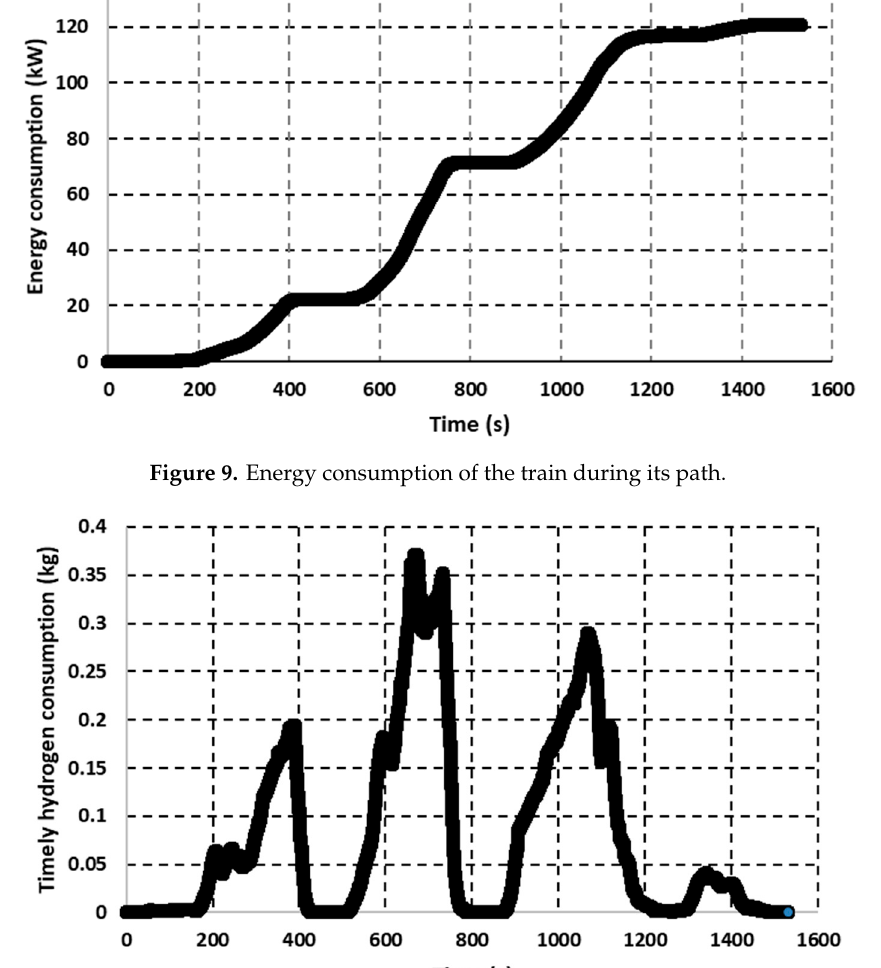
Figure 11. Hydrogen consumption for one trip. 4. Conclusions In this study, a hybrid fuel cell powertrain was conceptually designed for use in Union Pearson drive cycle in Toronto, Ontario, Canada. The repeatable drive cycle of the Union Pearson Express trains was extracted and used in obtaining the time-dependent power demand profile, “duty cycle”. To size the powertrain, four major subsystems were estimated as the primary components of interest, and the appropriate commercialized subsystems put forward in the calculations to investigate the feasibility of the implementing the topology of interest. The calculations showed that a hydrogen/battery hybrid powertrain was able to generate an average power demand of 283.3 kW and peak power demand of 1335 kW, which was needed to meet the drive cycle of the trains and the route geometry requirement based on an empirical data extracted from the working trains. In the development of the powertrain topology, the fuel cell packs were designed to supply the time average power demand of about 283.3 kW. The main reason was that the highest percentage of power demand shows to be lower than this value. Another reason for such a scenario was that the batteries can respond faster than the fuel cells. The fuel cell and battery pack were capable of satisfying the route energy demand. The battery packs were totally charged at the end of the route, and the regenerative braking portion was also considered in the route energy demand. Finally, the hydrogen demand for the proposed topology was estimated as 275 kg per day, and it turned out that the range of the powertrain, with this